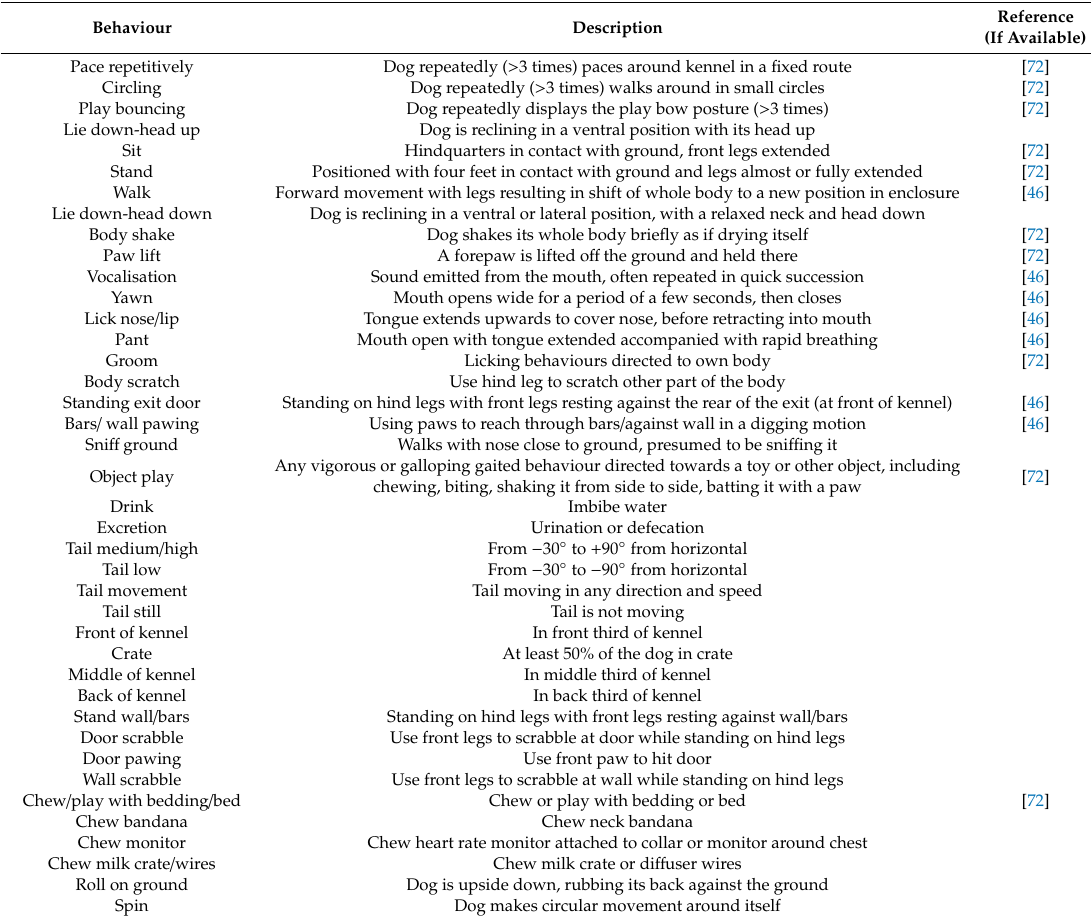
Table 1. Ethogram used for the measurement of the behaviour of dogs ( n = 60), with descriptors and